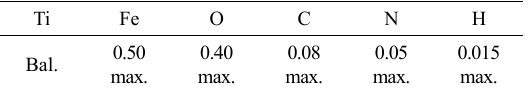
Table 1. Chemical composition of Ti cp (%